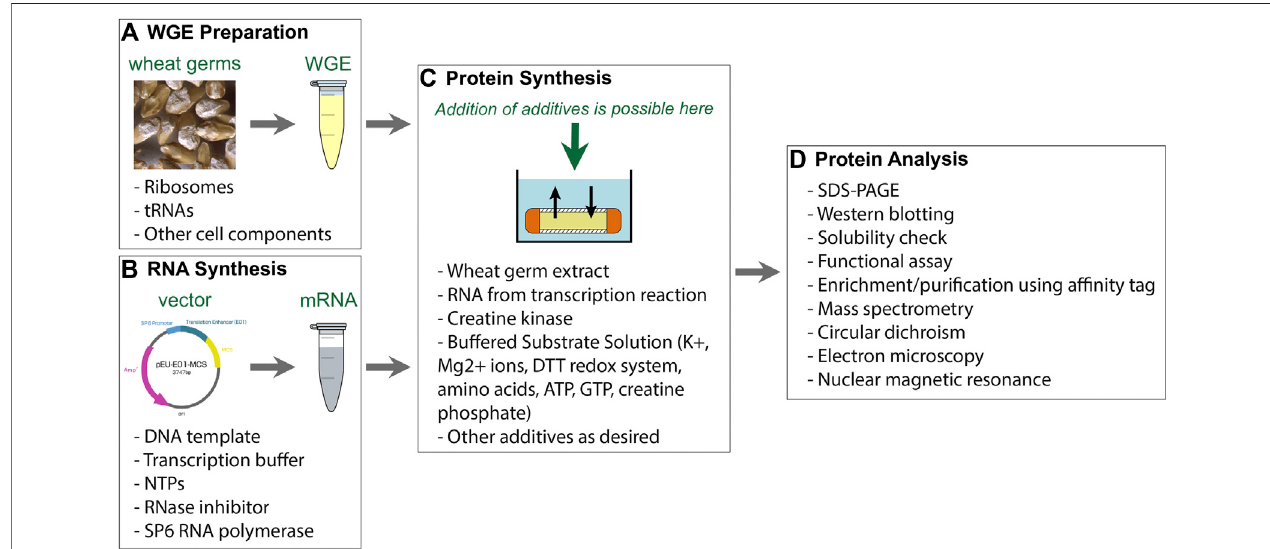
FIGURE 1 | Components of WG-CFPS described by Takai et al. (2010). (A) Wheat germ extract (WGE) can be prepared from nontreated durum wheat. Alternatively, commercially available WGE can be used. (B) The WG-CFPS uses expression templates having a SP6 promoter to drive RNA synthesis and an E01 translationalenhancertoinducecap-independenttranslation.ThesystemcanusecircularandlinearDNAtemplatestoholdacDNAencodingaprotein.Alternatively,T7 RNApolymerasecanbeusedaswellunderthesamereactionconditions.TheRNAisusedasatemplateforproteinsynthesis. (C) Thekeycomponentsforprotein synthesis are provided with the WGE. This includes the necessary ribosomes and tRNAs, but there are also other cell components in those extracts that may assist for example protein folding or possibly protein modi fi cation. Other key components are provided by the “ Buffered Substrate Solution ” which includes the amino acids, a DTT-based redox system, and a creatine kinase driving energy supply. Protein synthesis reactions can be modi fi ed as further explained in the text. (D) Protein synthesis can be con fi rmed by several different methods with the most commonly ones given in the fi